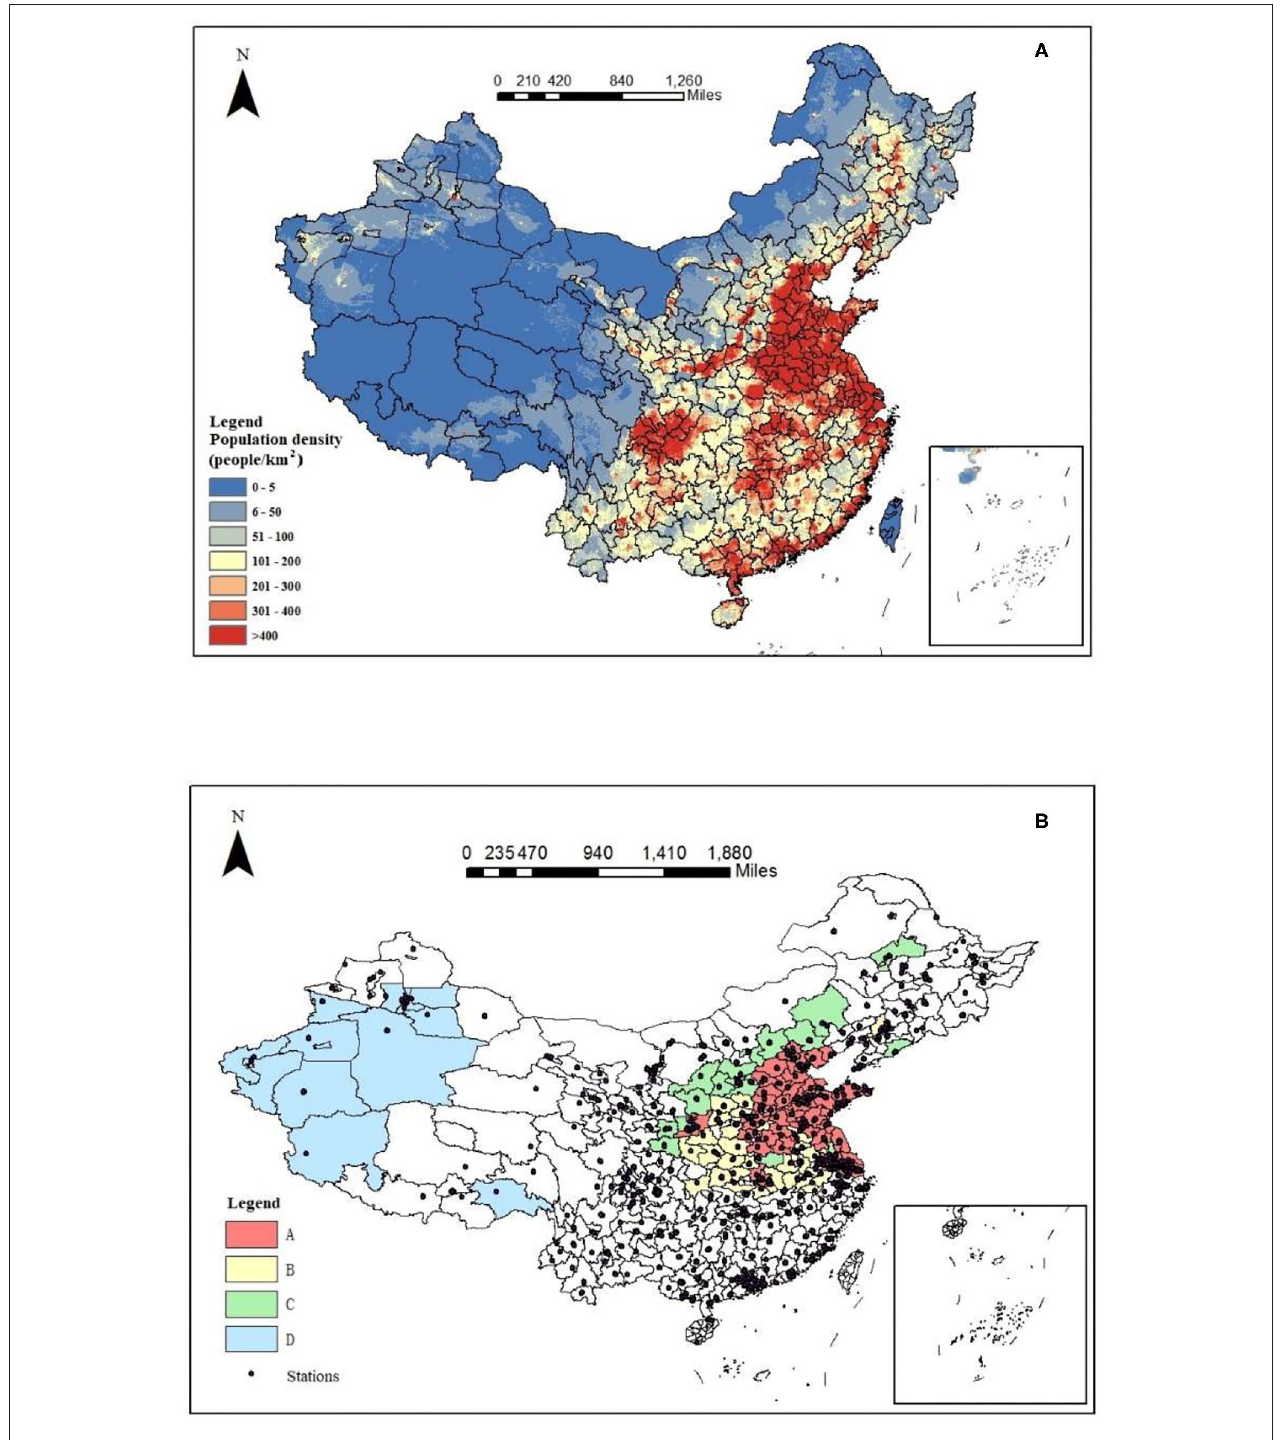
FIGURE 4 | Population density map (A) and the distribution of hotspots and monitoring sites (B) .